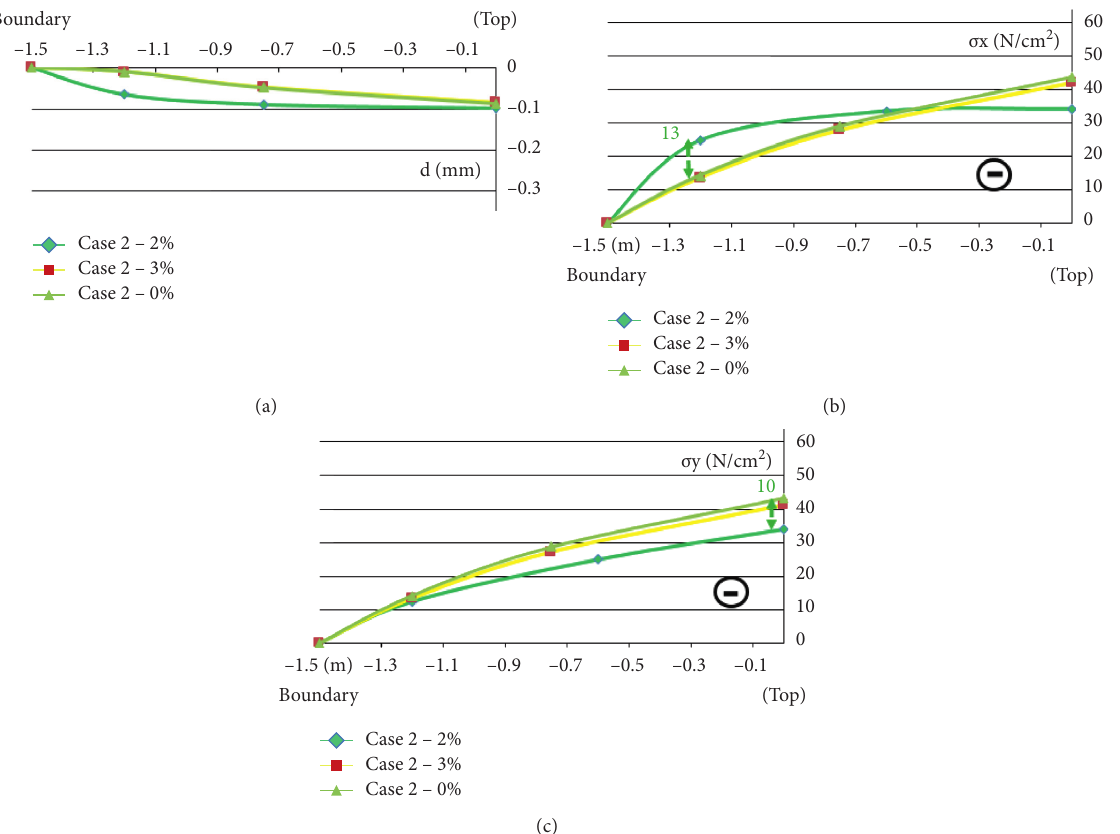
Figure 17: The change of percentage of steel fibres in concrete (Case 2): (a) vertical displacement of the shell; (b) stress σ σ y of